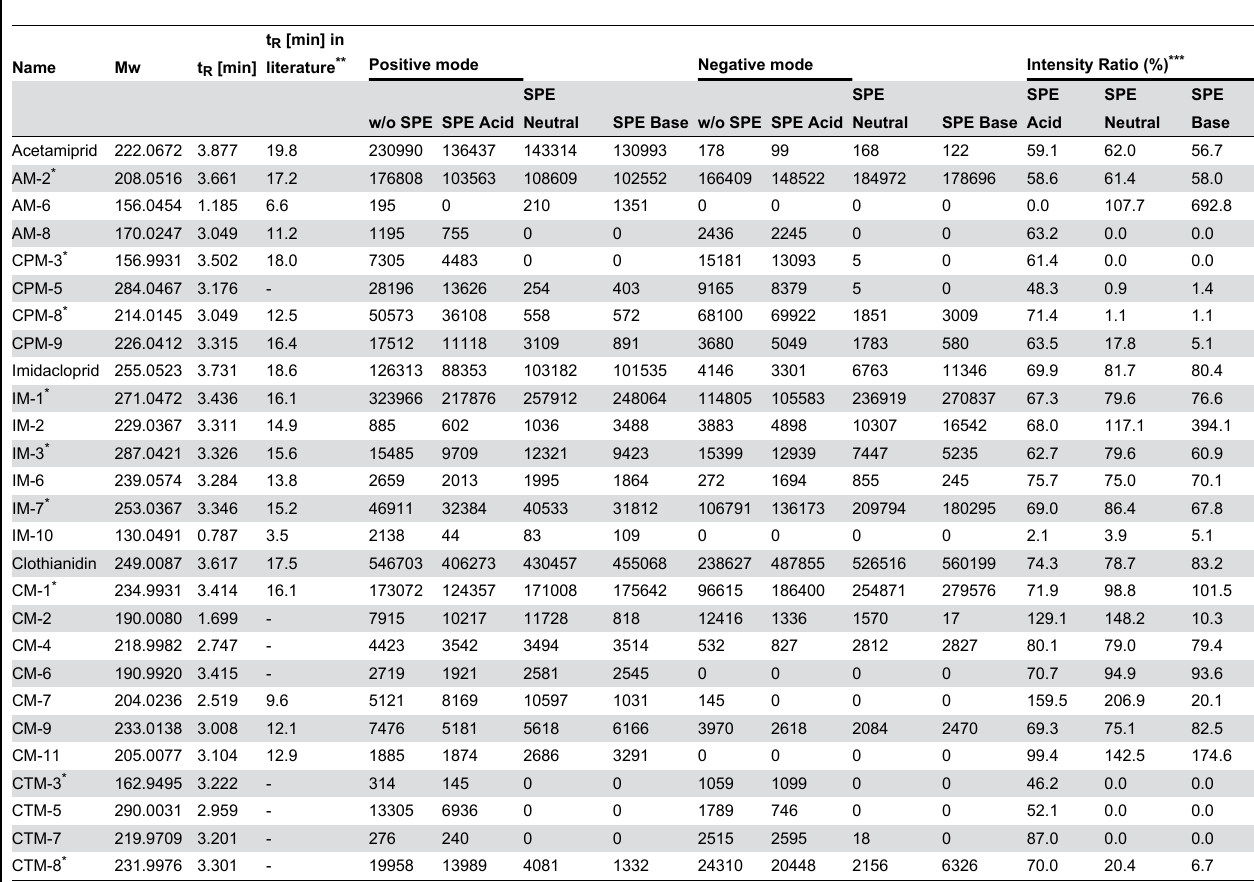
Table 5. The names, molecular weights, retention times and mean intensities of neonicotinoid pesticide metabolites detected in the urine of positive controls by LC/TOFMS